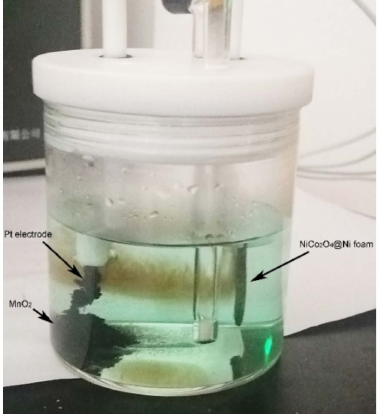
Figure 1. Photograph of electrodepositing MnO 2 onto NiCo 2 O 4